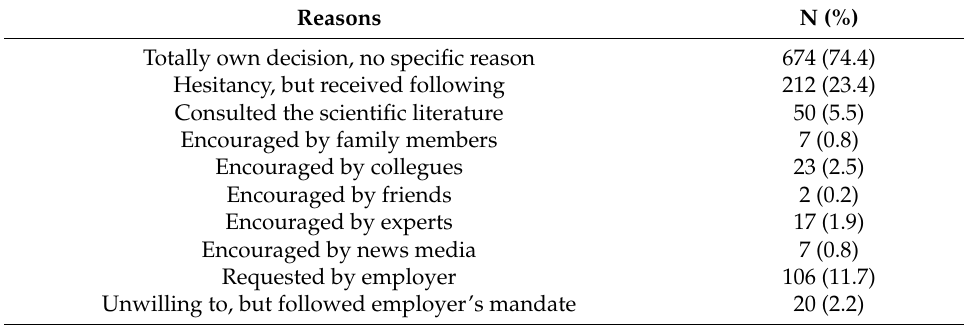
Table 4. Reasons for acceptance of COVID-19 vaccination in 906 subjects.